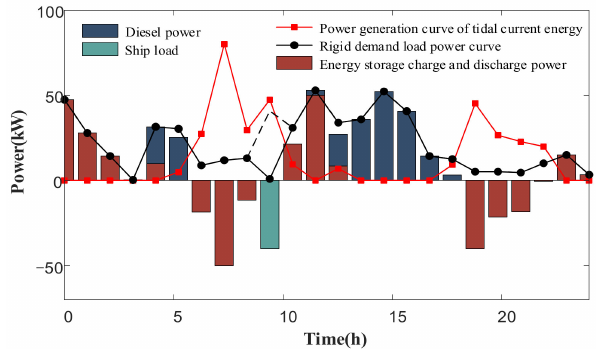
Figure 8. The results of the day-ahead